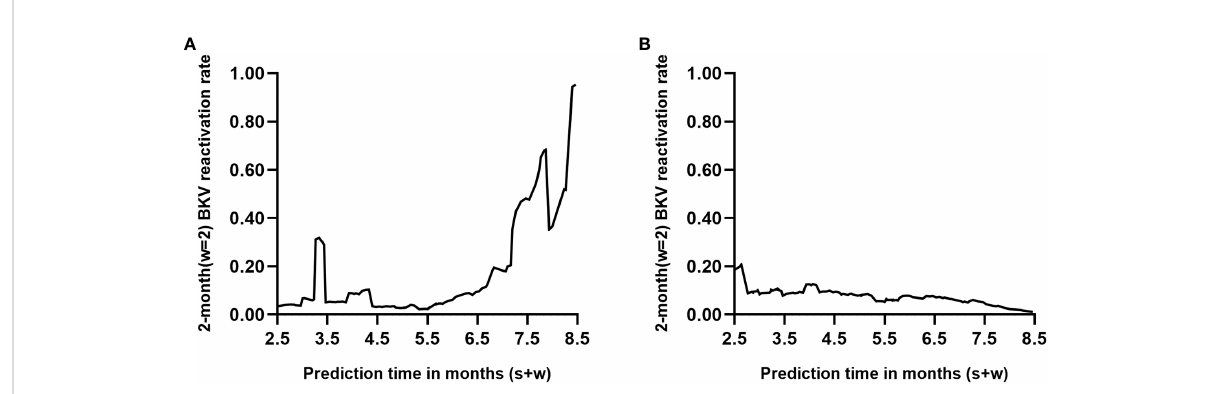
FIGURE 5 Individual prediction with the dynamic model (s=6, w=2). Each point on the curve refers to the probability of BK polyomavirus (BKV) reactivation in month s+2 based on follow-up records within s months posttransplant. (A, B) represent two renal transplant recipients of known endpoint events who turned out to be positive and negative within 8.5 months posttransplantation,